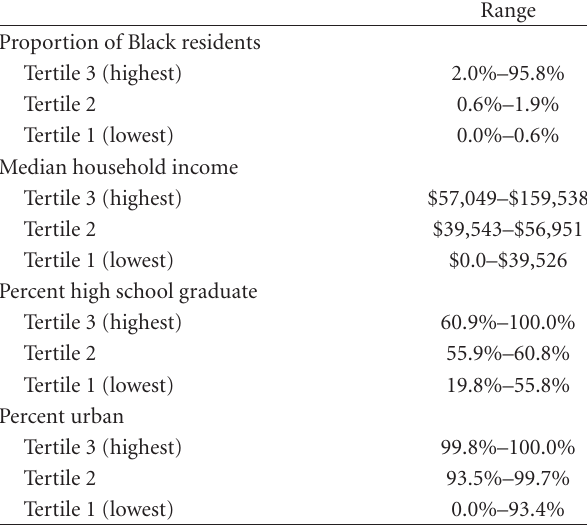
Table 4: Ranges of neighborhood-level variables.